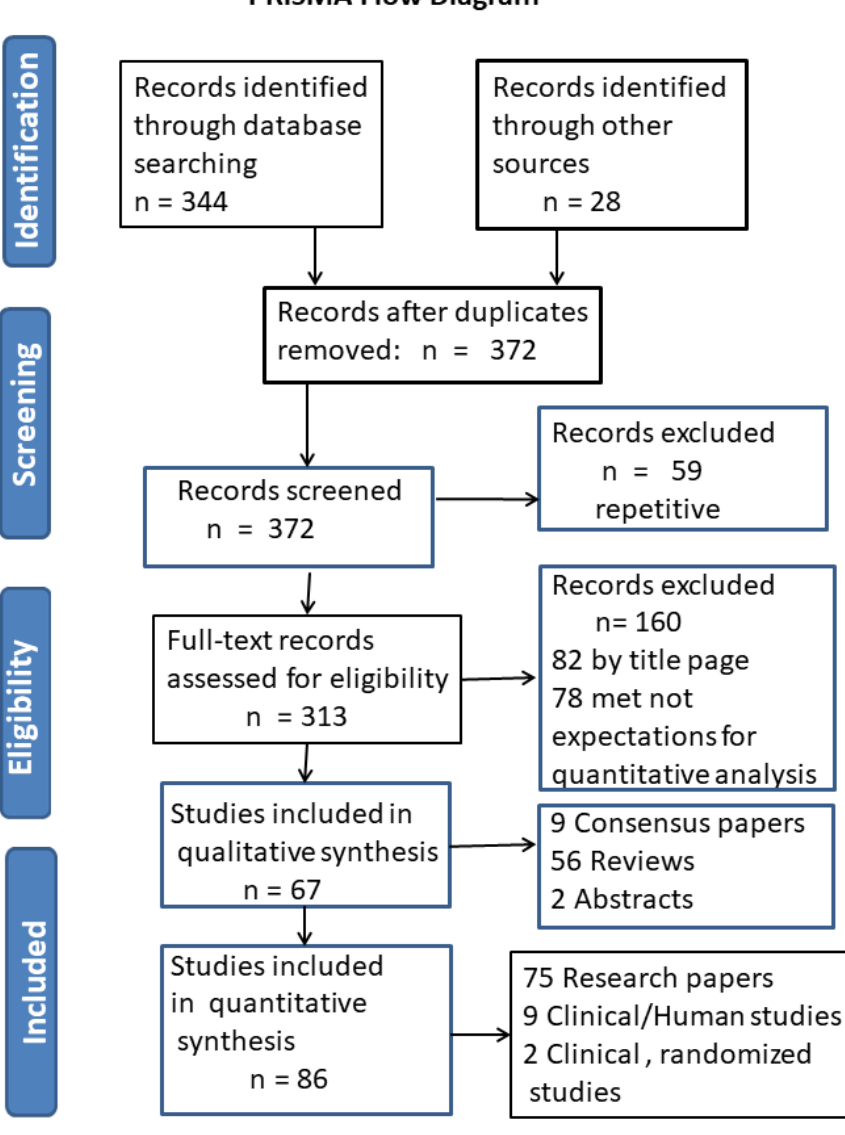
Figure A1. PRISMA flow diagram for studies including qualitative and quantitative analysis. PRISMA, preferred reporting items for systematic reviews and meta-analyses. Modified flow diagram according to